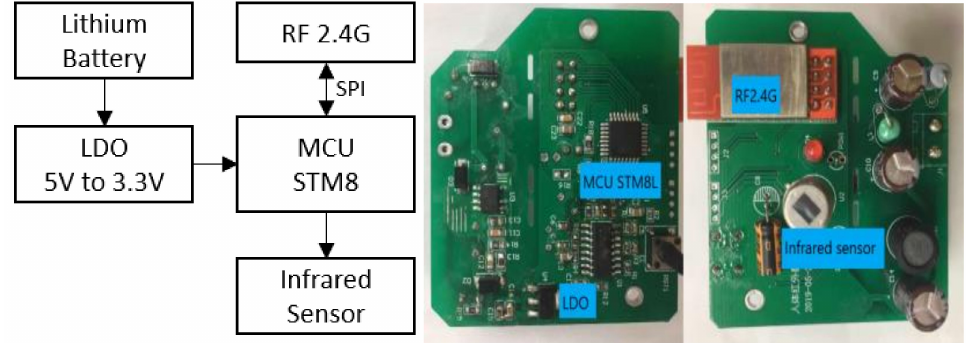
Figure 7. PIR sensor block diagram and working